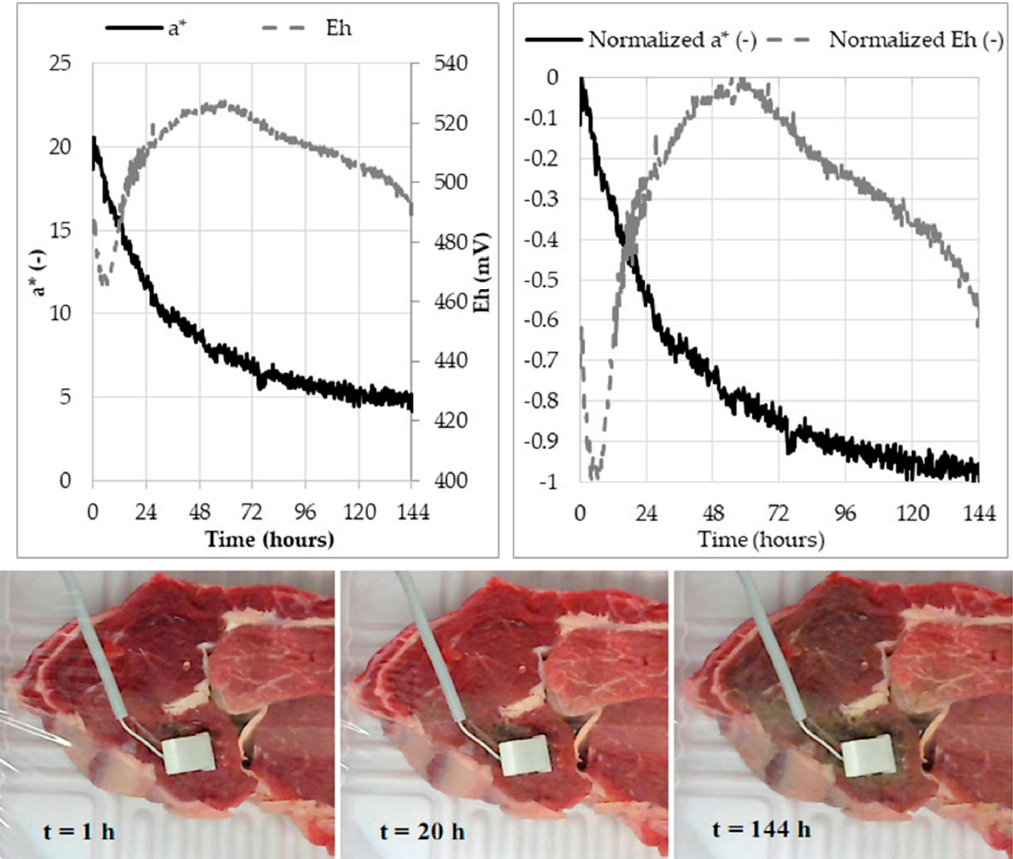
Figure 8. Monitoring the color transfer a* of a rib steak in a heat-sealed tray in air and the redox potential, E h , measured with a built in-house redox probe at 4 °C as a function of time ( left ), the values normalized as a function of time (at right ) and the associated photos showing their color transfers at t = 1 h, t = 20 h, and t = 144 h.